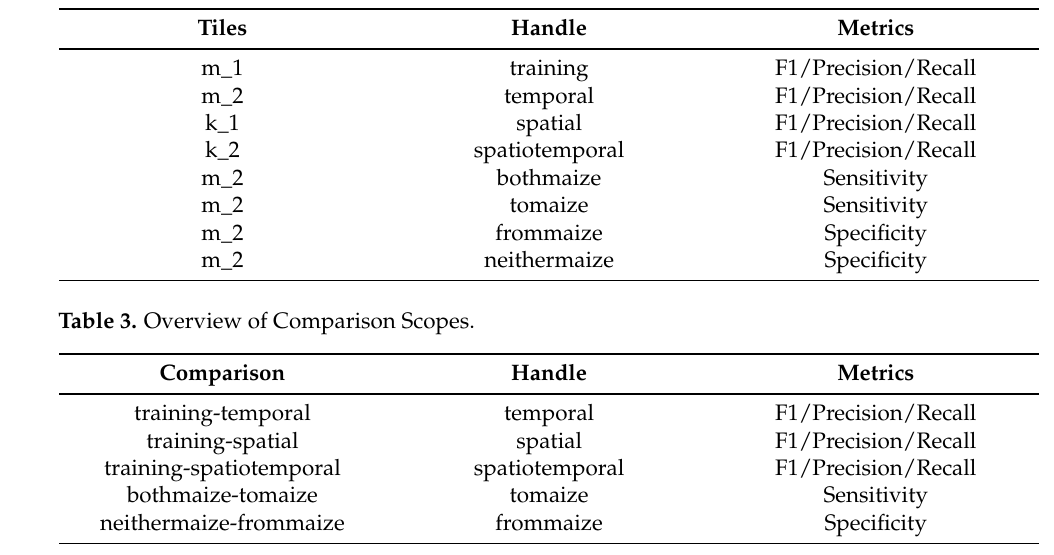
Table 2. Overview of Validation Scopes.